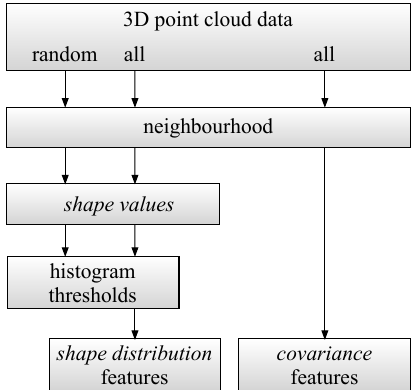
Figure 1: Feature calculation workflow. To calculate shape distri- bution features, histogram binning thresholds have to be acquired first as described in Section